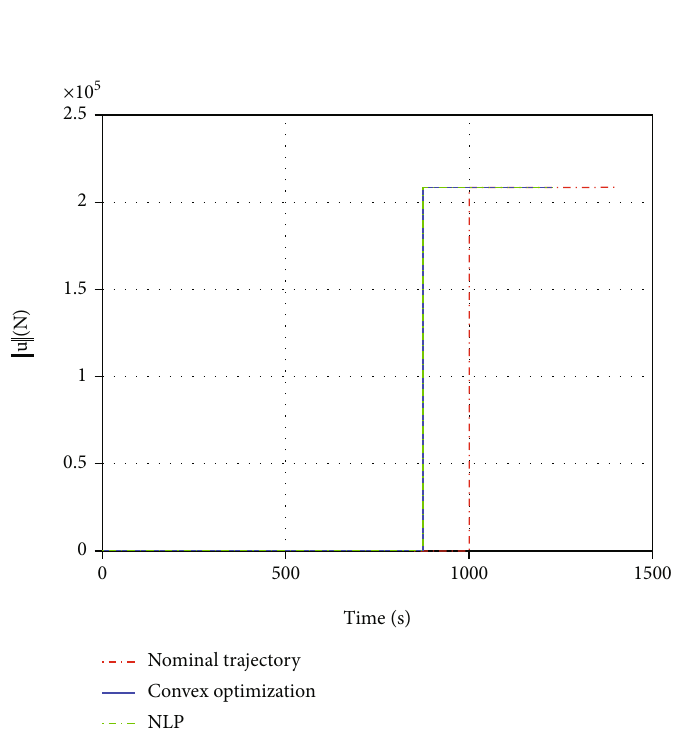
Figure 14: Curve of u